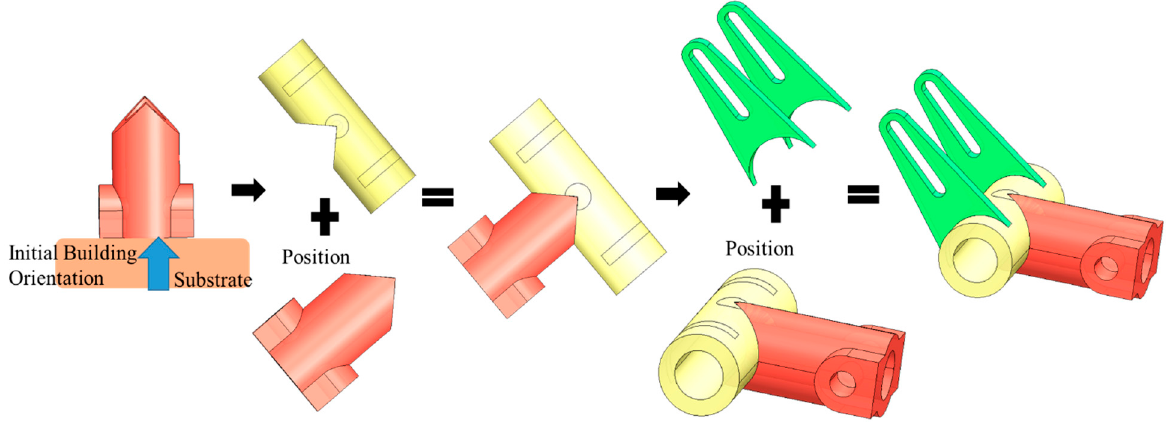
Figure 14. Process Planning with first defined initial building orientation for model (b). The accumulated trajectories for this geometry are shown in Figure 15.